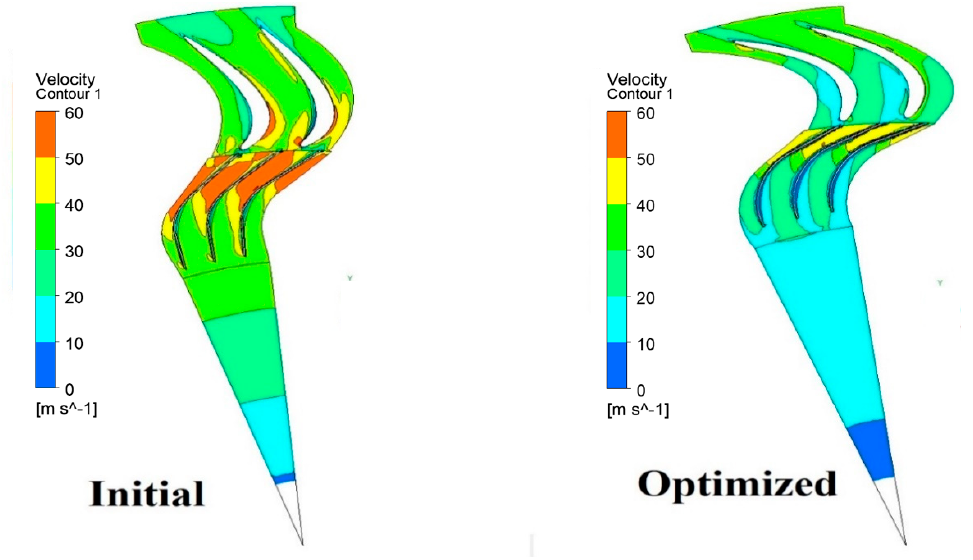
Figure 13. Comparison of the velocity contour of the initial and the optimised geometries at ∆ P 0 = 1400 Pa.